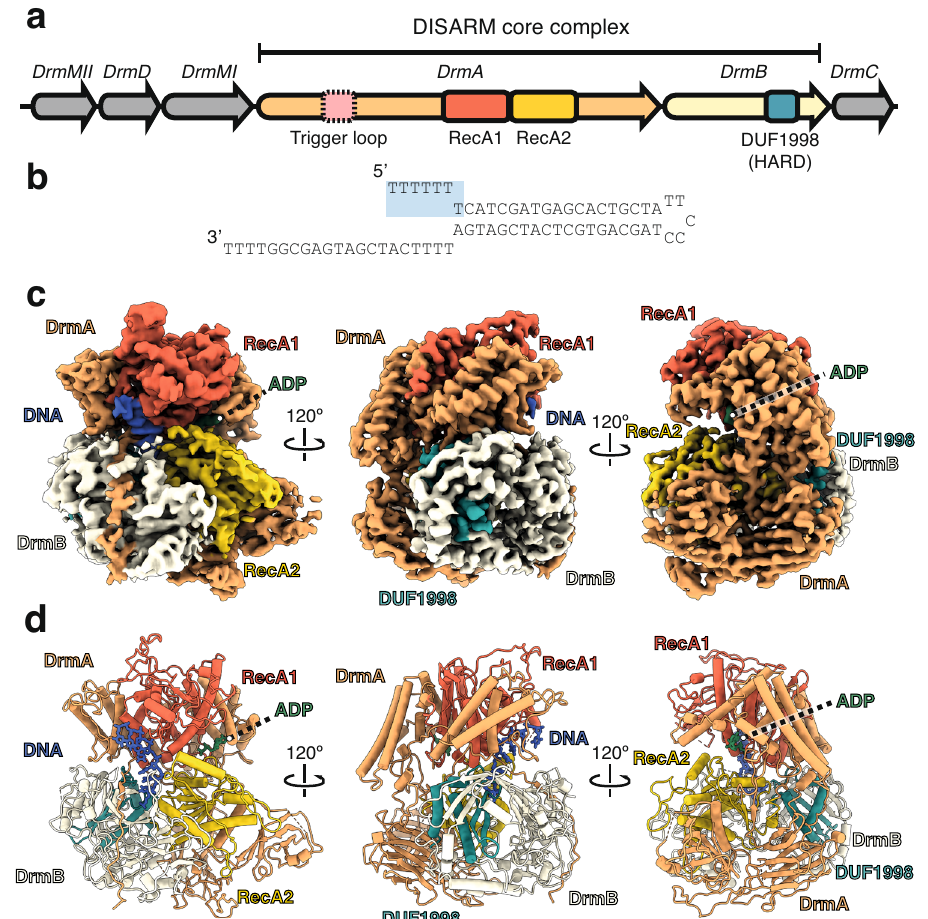
Fig. 1 Architecture of the DrmAB:ADP:DNA complex. a Serratia sp. DISARM operon. Conserved DISARM core components DrmA and DrmB are colored by structural domains. Presence of DrmA trigger loop (residues 176-232) is mutually exclusive with DNA binding and is denoted by a dashed box. b DNA substrate used for structure determination. Seven 5 ’ bases that are present in our structure are highlighted blue. c Cryo-EM reconstruction of DrmAB:ADP:DNA complex colored as in ( a ). ssDNA is shown in blue and ADP in green. d Atomic models built into the cryo-EM map ( b